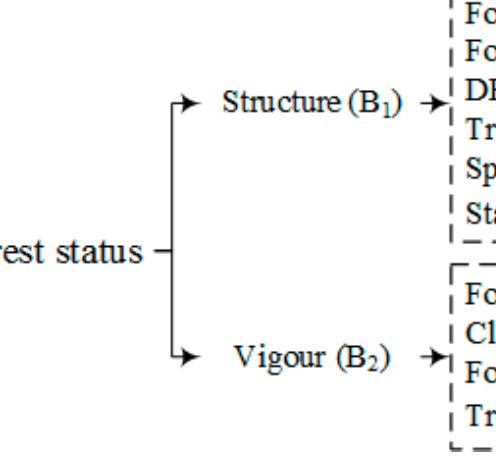
Figure 2. The evaluation index system of forest state.